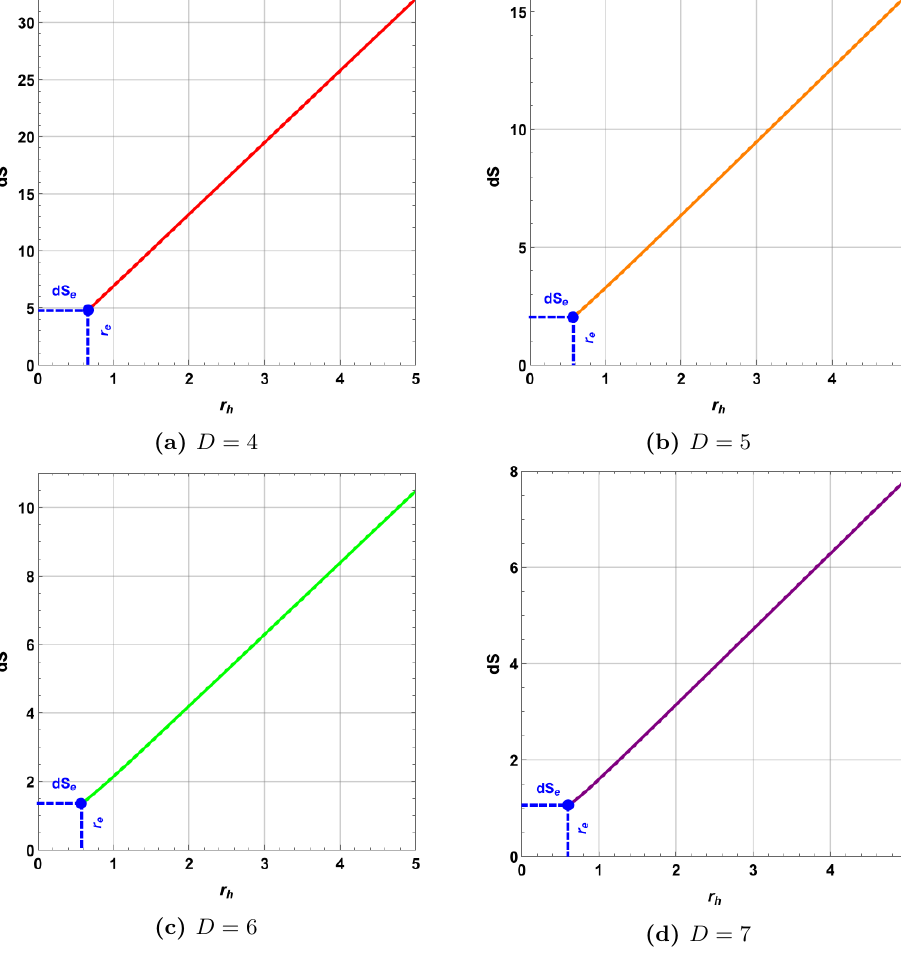
Figure 3. Entropy variation dS as a function of event horizon radius r h for different dimensions with | p r | = 1 , Q = 1 , l = 1 and dQ = 0 . 1 h